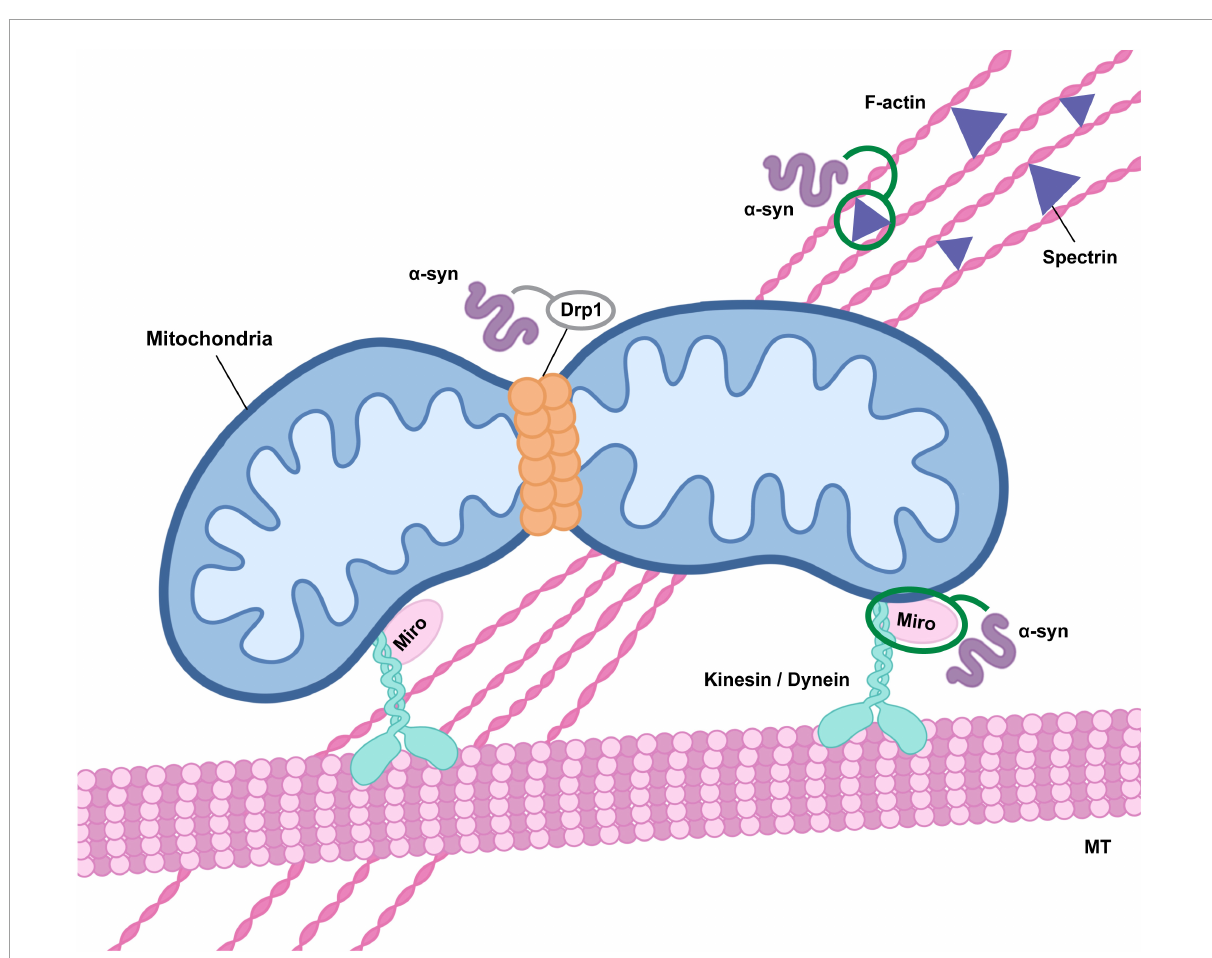
FIGURE1 Alpha-synuclein influences mitochondrial transport and fission. Alterations in alpha-synuclein ( α -syn) function may affect mitochondrial fission through direct effects on Drp1 activity and mitochondrial translocation, although the precise impact has not been clearly defined (indicated in gray). Oligomeric alpha-synuclein may also inhibit Drp1 trafficking to mitochondria as a result of alterations in actin cytoskeletal dynamics mediated by an association with the actin-cross linker spectrin. In addition, alpha-synuclein oligomers modulate Miro activity, either through promotion of Miro protein stability or retention in the outer mitochondrial membrane, influencing microtubule (MT) transport via dysregulation of kinesin or dynein